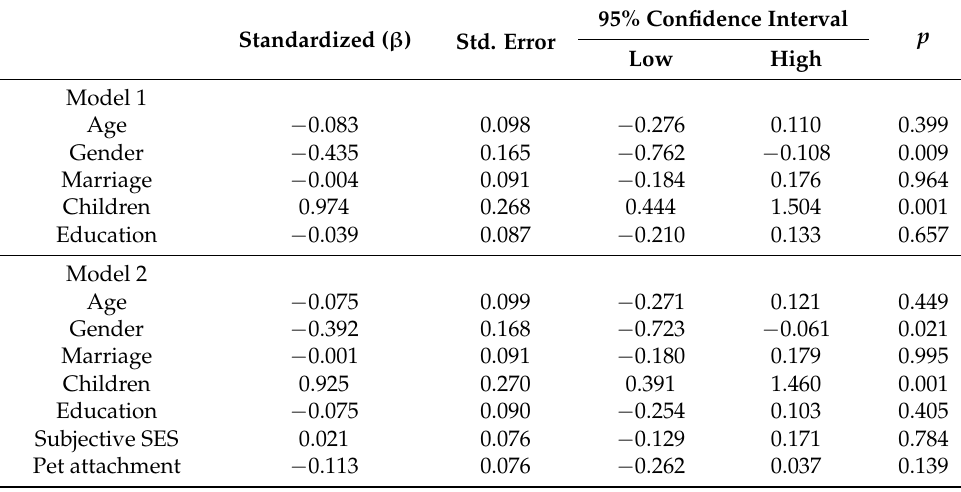
Table 3. Summary of the hierarchical regression model coefficients ( N =